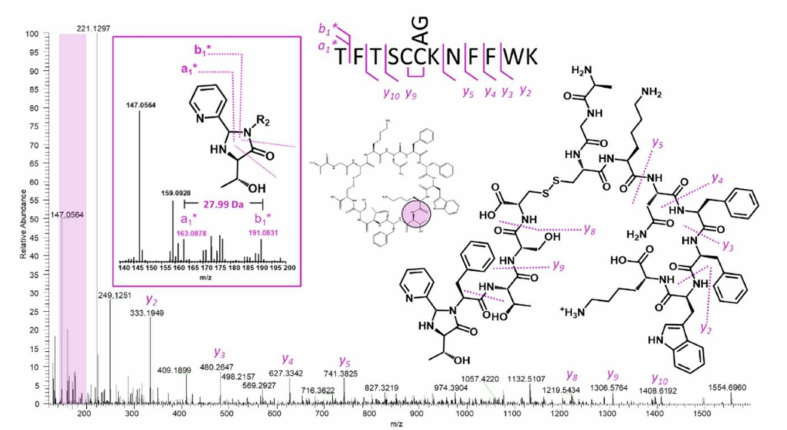
Figure 5. MS/MS analysis of the hydrolyzed and 2PCA-modified somatostatin parent mass results in the easily interpretable spectrum shown above. The inset shows the two diagnostic ions across imidazolidinone that result in confident identification of the most N-terminal